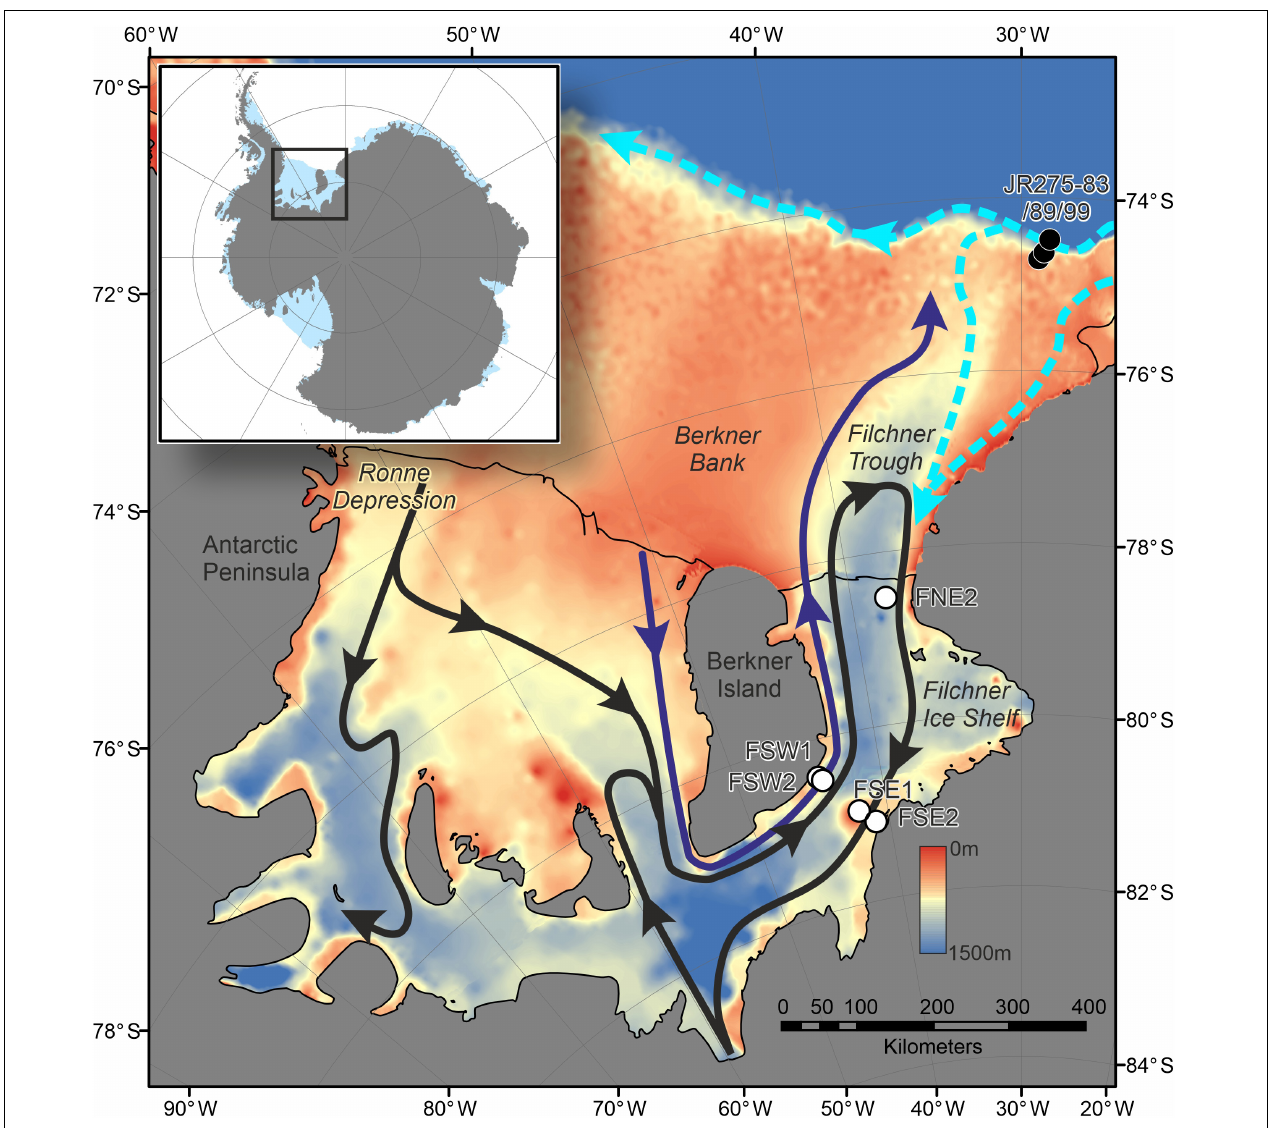
FIGURE 2 | Map showing location of drill sites on Filchner Ice Shelf (FSW1-2, FSE1-2, and FNE2), comparable samples from continental shelf collected during JR275 as well as the major sub-ice shelf circulation. Black arrows show flows derived from High Salinity Shelf Water (HSSW) from the Ronne Depression. Purple arrow shows the flow from HSSW formed over Berkner Bank (Nicholls, 2004). Ice Shelf Water (ISW) exits along the eastern margin of Filchner Trough, with a possible seasonal influx of modified Warm Deep Water (mWDW) (Darelius et al., 2016). Dashed light blue arrows represent the flow of the slope front and coastal currents (Nicholls et al., 2009). Bathymetry is derived from ETOPO1 (NOAA National Geophysical Data Center, 2009).